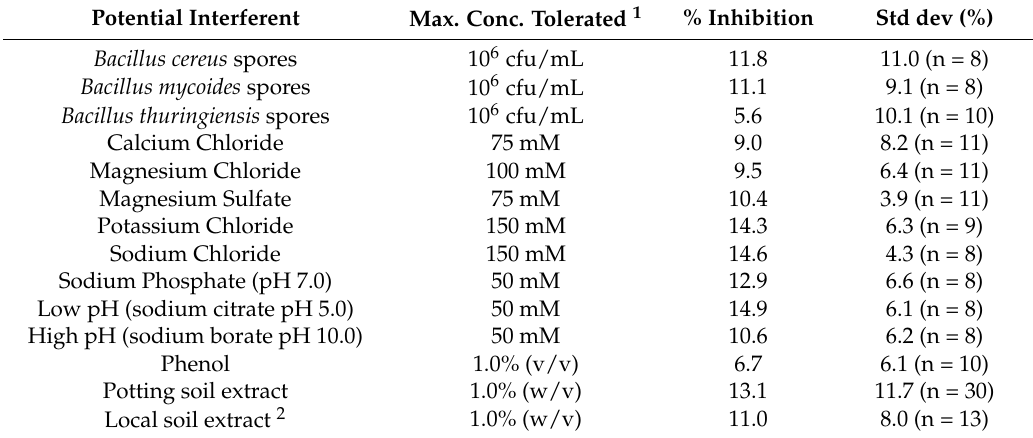
Table 1. List of the maximum tolerated concentration of potential environmental interferents and %